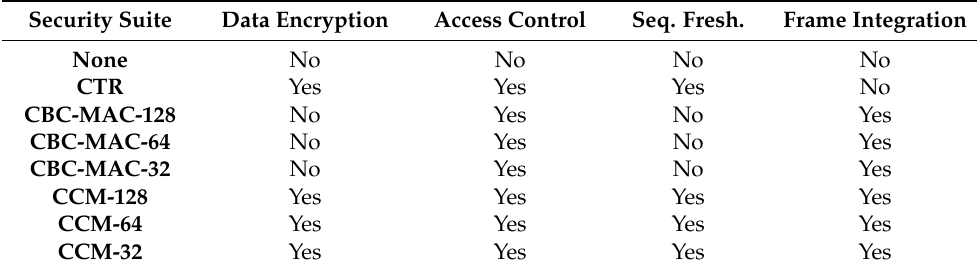
Table 5. Security Suits for IEEE